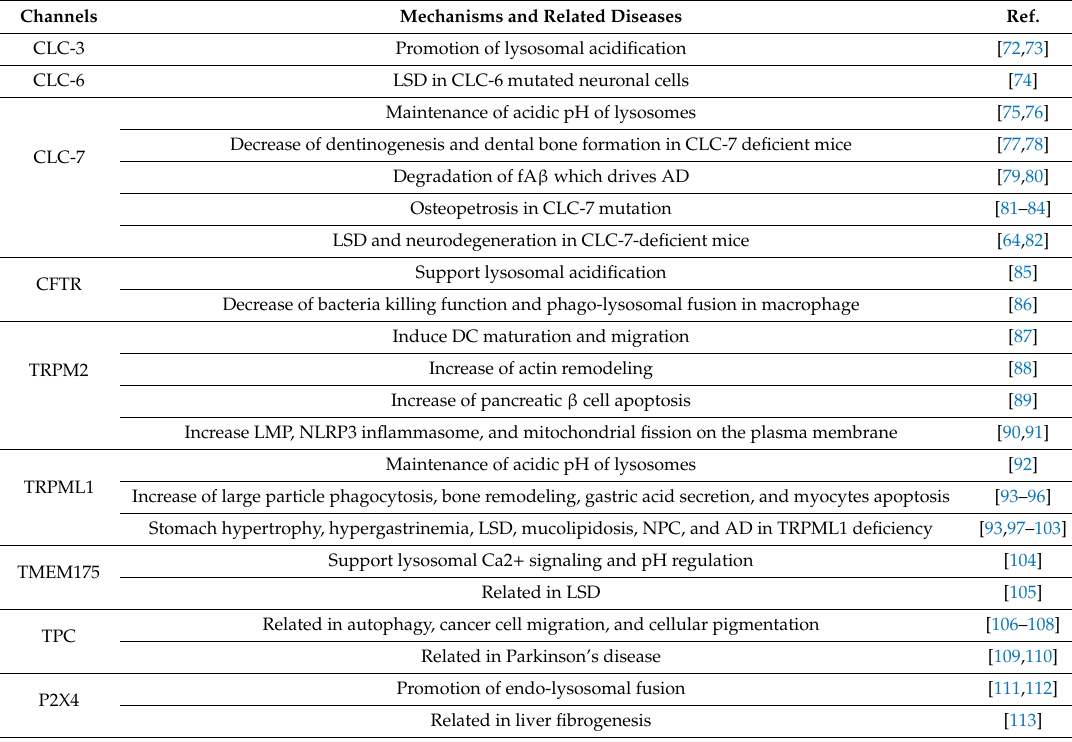
Table 1. The relationship between lysosomal ion channels and cellular